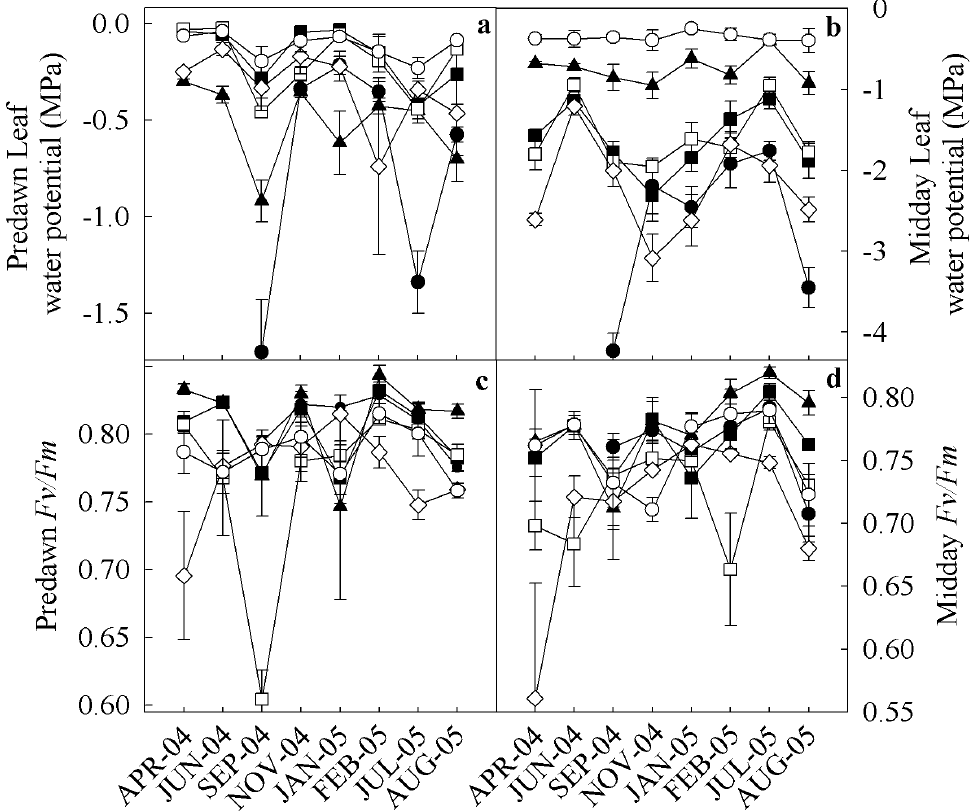
Figure 2 - Seasonal variation at predawn, midday in leaf water potential (panels a and b ) and chlorophyll a fl uorescence (panels c and d , respectively). Species are represented as follows: closed squares – Byrsonima ( ■ ); closed triangles – Clusia ( ▲ ); closed circles – Erythroxylym ( ● ); open squares – Eugenia ( □ ); open diamonds – Ocotea ( ◊ ) and open circles – Protium ( ○